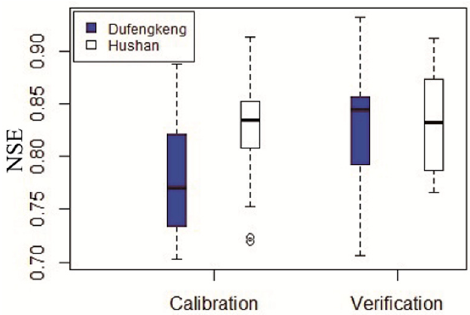
Figure 5. Boxplots of the Nash ‐ Sutcliffe efficiency (NSE) in the calibration and validation periods for the Xin’anjiang model.